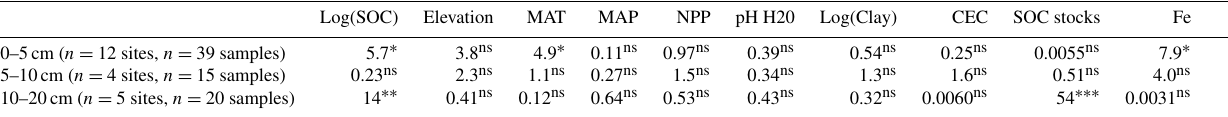
Table 6. Results of the mixed effect model testing (cid:49) 14 C for the effects of environmental variables. Site and core were always taken as random effects, whilst log(SOC), Elevation, MAT, MAP NPP, pH and log(Clay) are taken separately as fixed effects. The table shows F-values and significant effects are indicated are indicated with ∗ , ∗∗ and ∗∗∗ for p values p< 0 . 05, p< 0 . 005 and p< 0 . 0005. p >0.05 are indicated with superscript